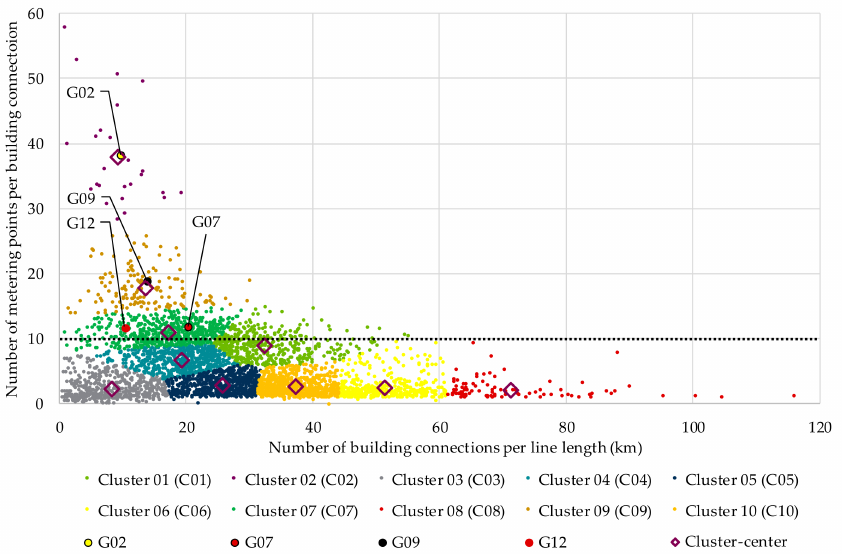
Figure 35. Analyzed low-voltage grids with more than 10 metering points per building connection in the cluster evaluation based on